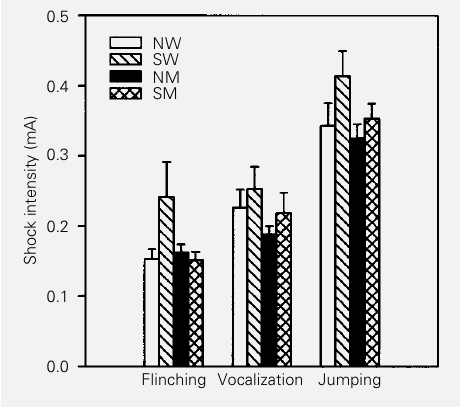
Figure 2 - Flinching, vocalization and jumping thresholds of the experimental groups submitted to electric shock at 70 days of age. The vertical bars indicate the SEM of 12 rats. NW, Non- stimulated well-nourished; SW, stimulated well-nourished; NM, non-stimulated malnourished; SM, stimulated malnourished. Flinching < vocalization < jump- ing thresholds (P<0.05, ANOVA followed by Newman-Keuls